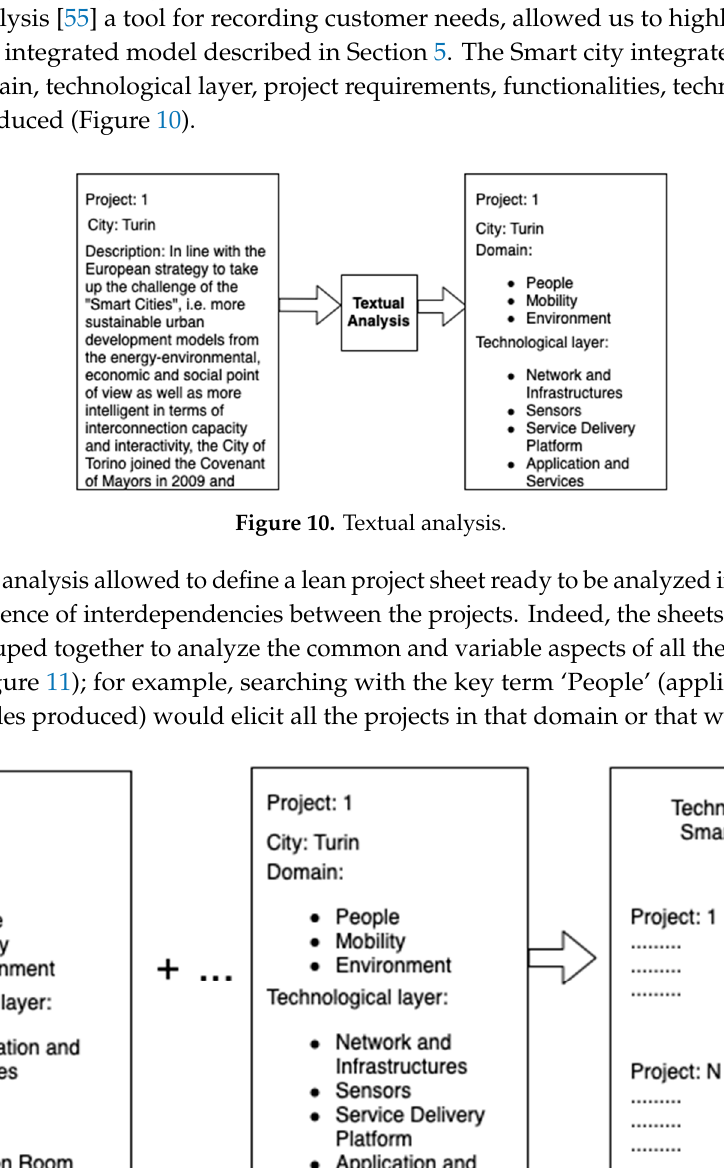
Figure 9. Percentage of smart project per technological depth.